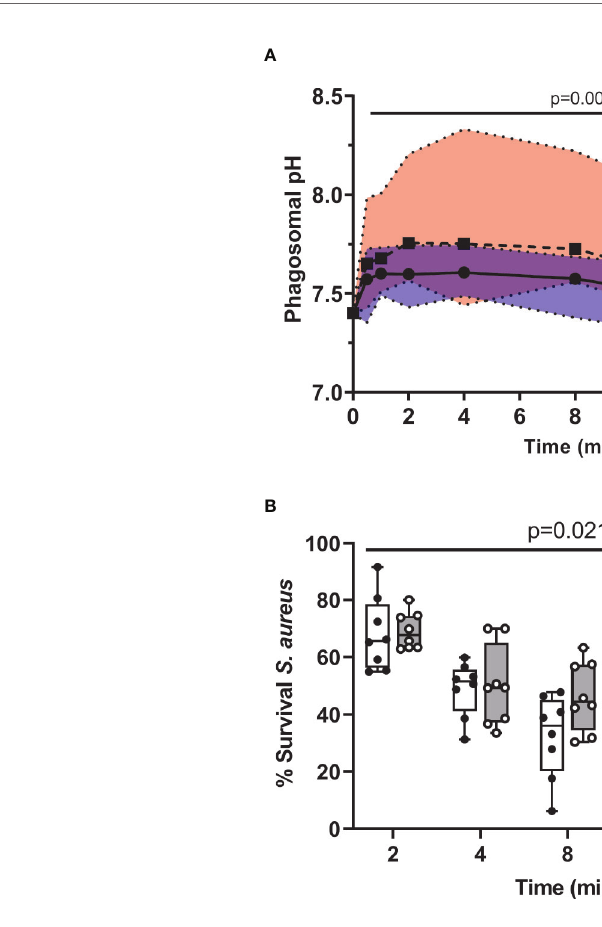
FIGURE 6 | Altered pH negatively impacts killing of phagocytosed bacteria. (A) Time course of phagosomal pH changes assessed using SNARF labelled C. albicans phagocytosed by neutrophils of HC ± ZnCl 2 (100 µM). Phagosomes of ZnCl 2 treated HC neutrophils demonstrated signi fi cantly increased pH (n = 3 subjects per group, mixed effects model with Tukeys ’ post hoc test). (B) Time course of S. aureus killing (0.5 x 10 7 c.f.u./ml) by HC neutrophils treated with 100 µM